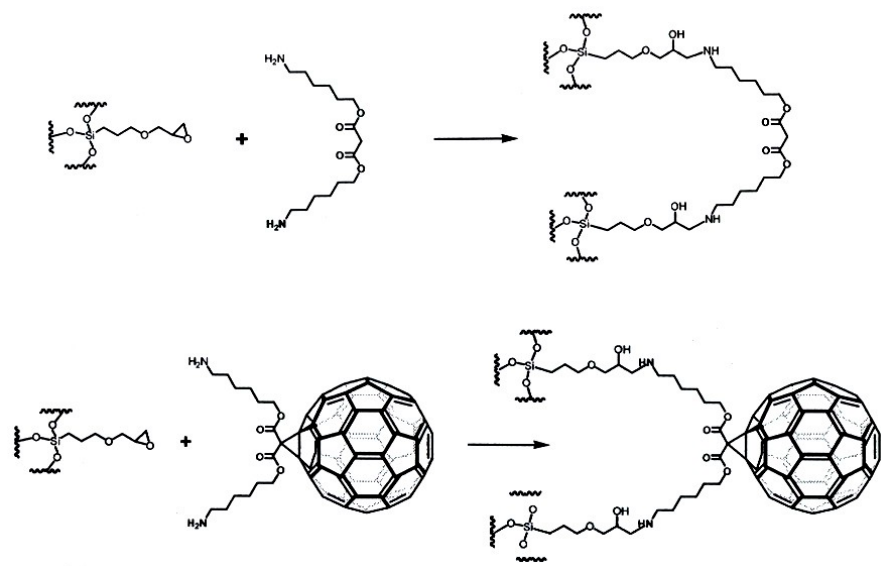
Figure 28 . Structure of the silica-bonded spacer stationary phase ( top ) and the silica-bonded C 60 stationary phase ( bottom ) [110]. Reproduced from A. Bogdanski, Doctoral Thesis, University of Tübingen, Tübingen, Germany, 2007. Table 5. Apparent complexation constants K rel of cyclodextrins and silica-bonded [60]fullerene (C 60 ) related to CD6 ( α -cyclodextrin) [110].